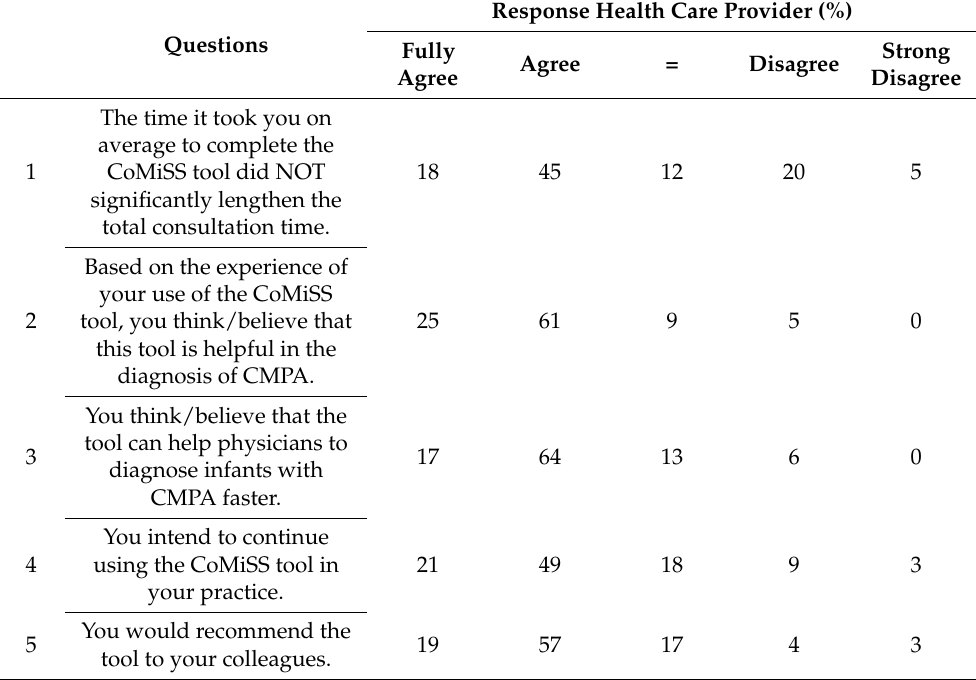
Table 12. Satisfaction questionnaire for health care